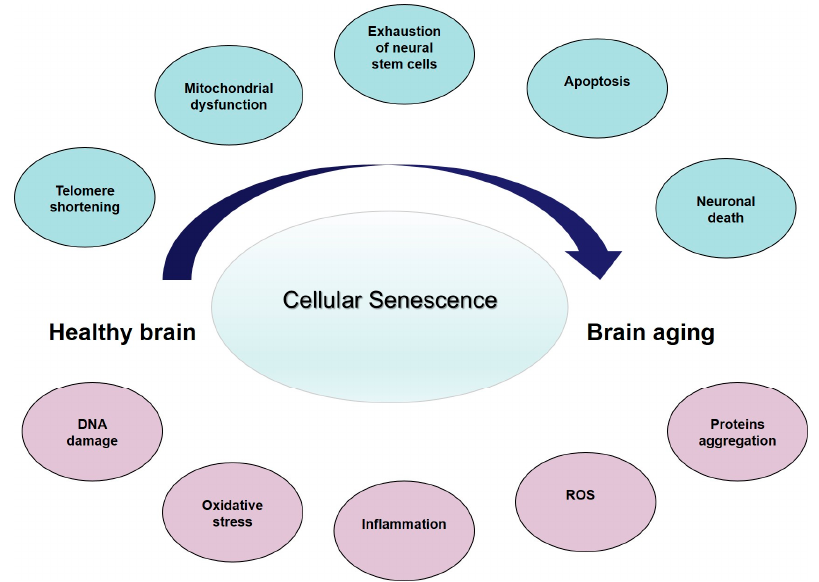
Figure 1. From healthy brain to brain aging: insights into age-related changes (ARCs). Some proposed ARCs with cellular senescence as the central contributing factors to age-associated brain tissue dysfunction. Blue circles represent the main changes while in pink represent the consequences and downstream events. ROS: reactive oxygen species.